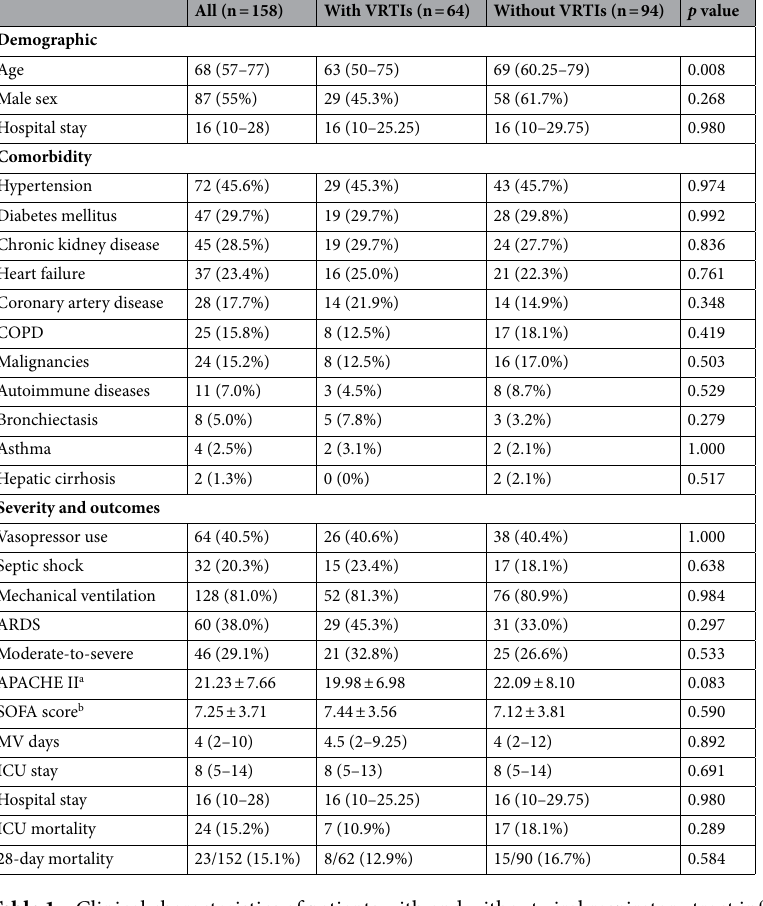
Table 1. Clinical characteristics of patients with and without viral respiratory tract infections (VRTIs). VRTI viral respiratory tract infection, COPD chronic obstructive pulmonary disease, ARDS acute respiratory disease syndrome, APACHE II Acute Physiologic Assessment and Chronic Health Evaluation II, SOFA Sequential Organ Failure Assessment, MV mechanical ventilation, ICU intensive care unit. a On the ICU admission day. b On the day obtaining the first respiratory specimen.